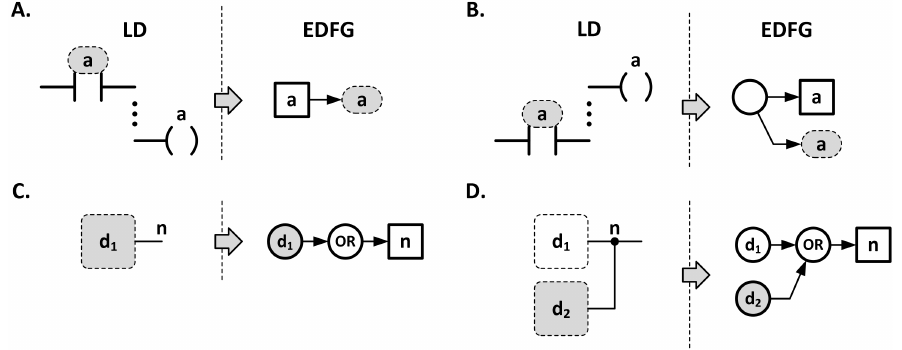
Figure 4. General EFG construction rules for LD mapping of variable access, according to fast LD ( A , B ) and multiple logic outputs driving a common node ( C , D ).